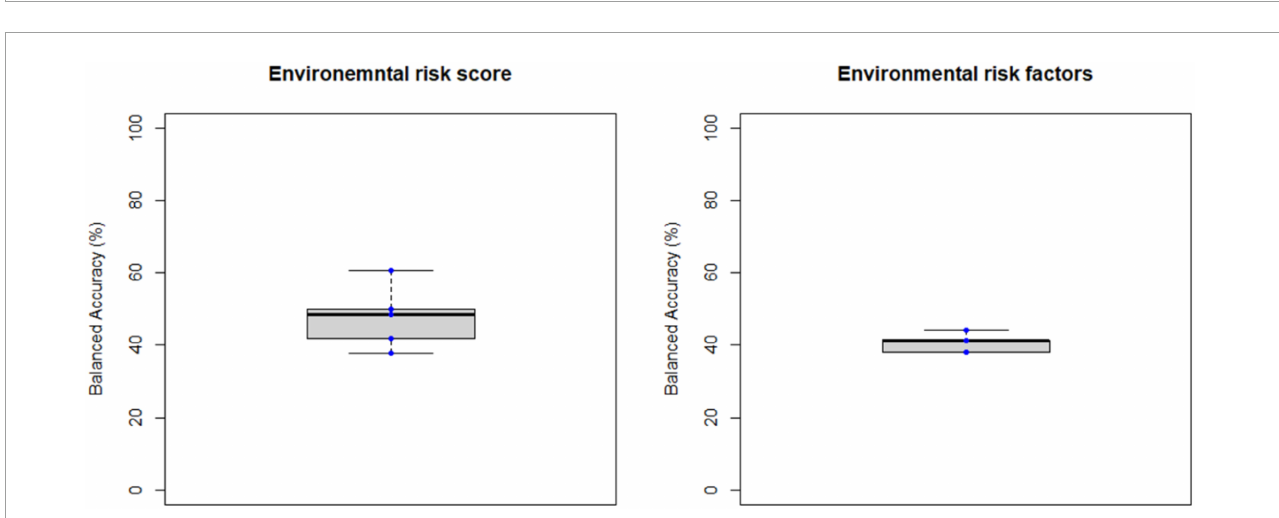
FIGURE6 Balanced accuracy across bootstrapped samples for each model trained with the environmental risk score or with each environmental risk factors as features. Dots represent the balanced accuracy value in each of the 5 bootstrapped samples and are red colored if the balanced accuracy is statistically significant (i.e., p < 0.05) or blue colored if it is not (i.e., p > 0.05). The statistical significance of the balanced accuracy in each bootstrapped sample was evaluated through permutation testing.